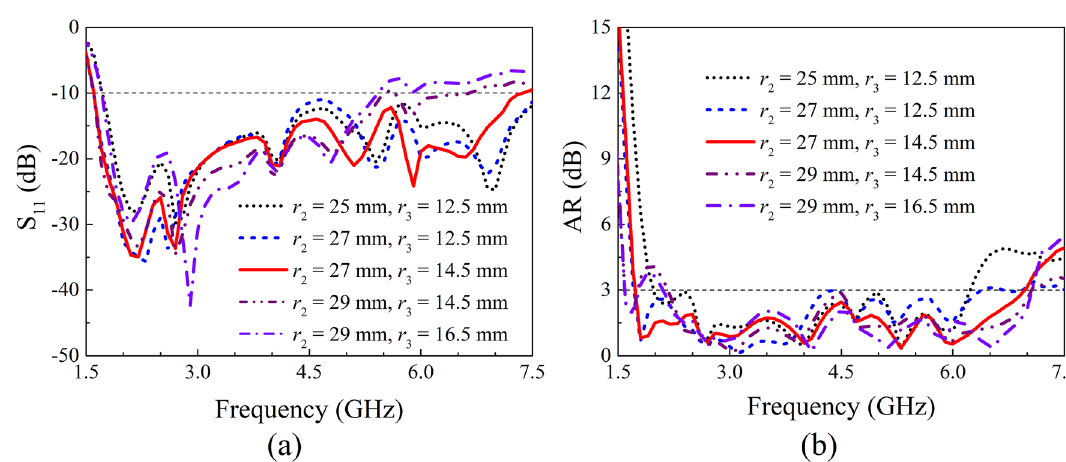
Figure 5. Effect of different r 2 and r 3 on S 11 and AR, respectively. ( a ) S 11 , ( b )